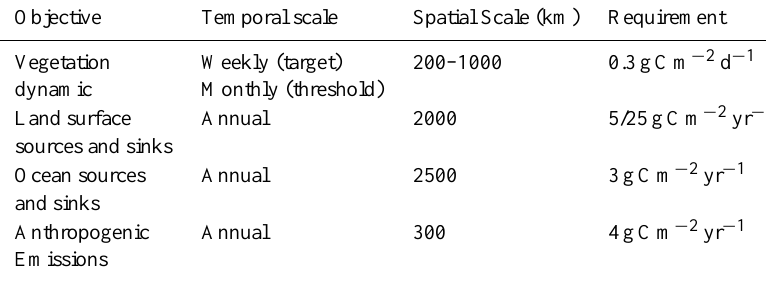
Table 2. Quantitative requirements for four different objectives discussed in this